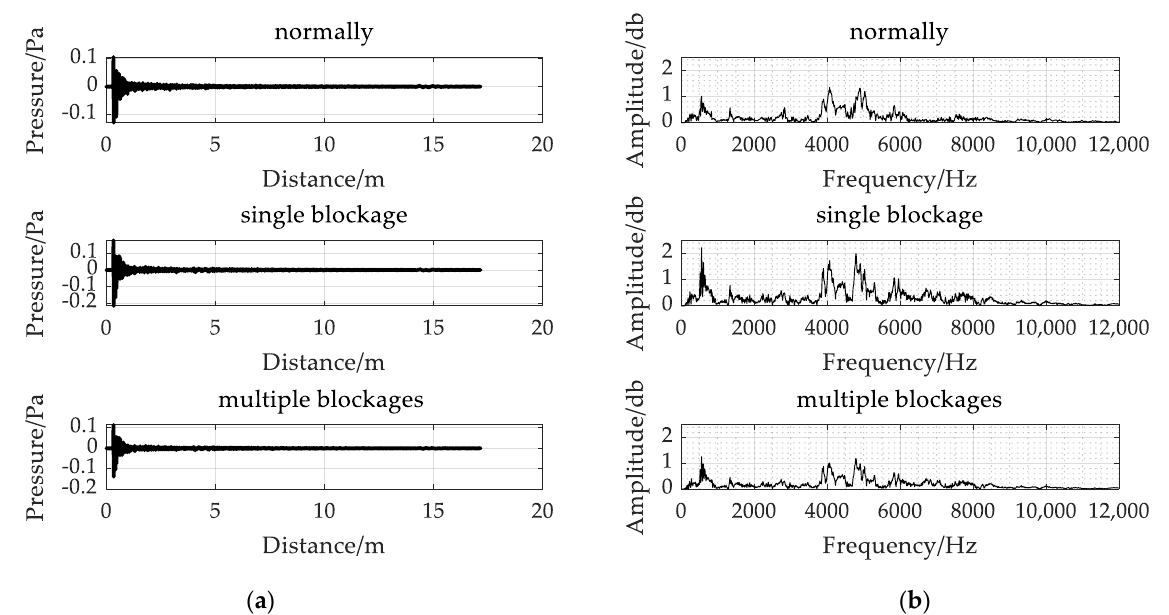
Figure 3. Time domain and frequency domain diagrams of pipe conditions (normally, single blockage, multiple blockages): ( a ) time domain; ( b ) frequency domain.